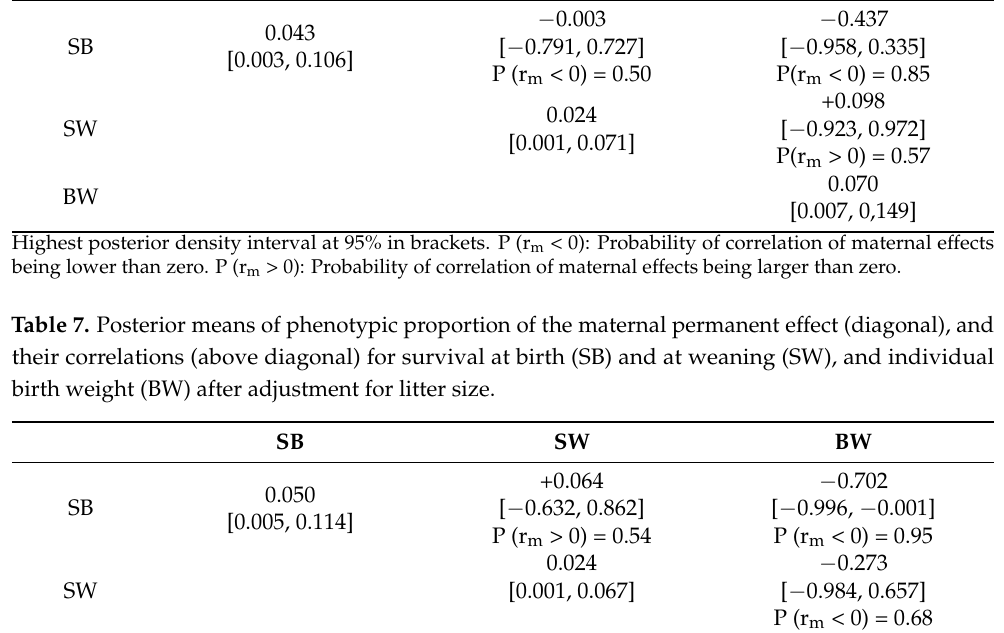
Table 6. Posterior means of phenotypic proportion of the maternal permanent effect (diagonal), and their correlations (above diagonal) for survival at birth (SB) and at weaning (SW), and individual birth weight (BW). SB SW BW